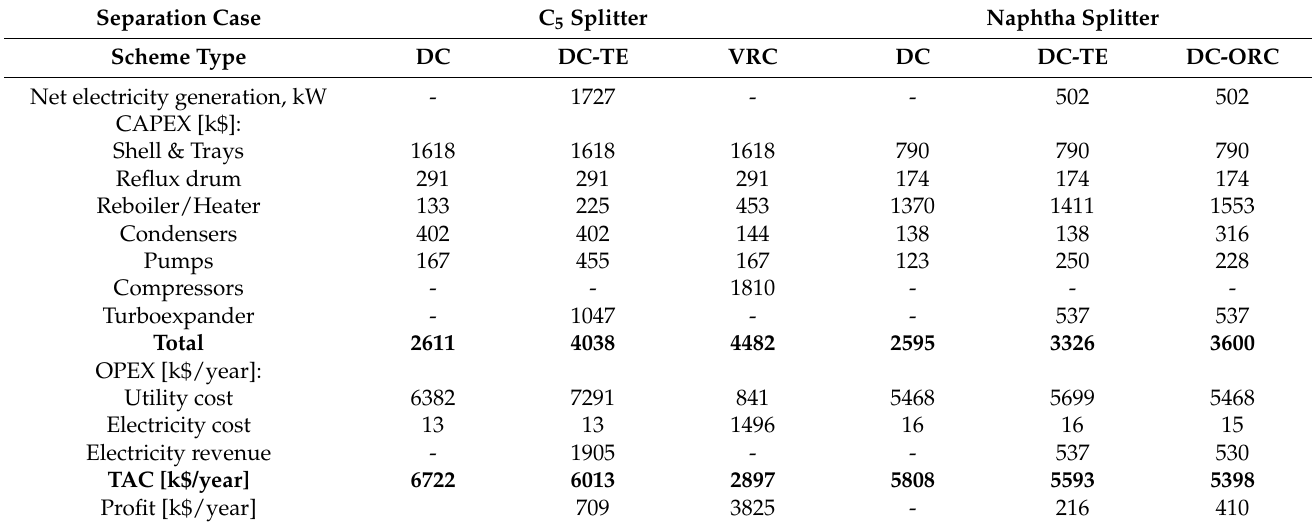
Table 4. Economic analysis of distillation integrated with a